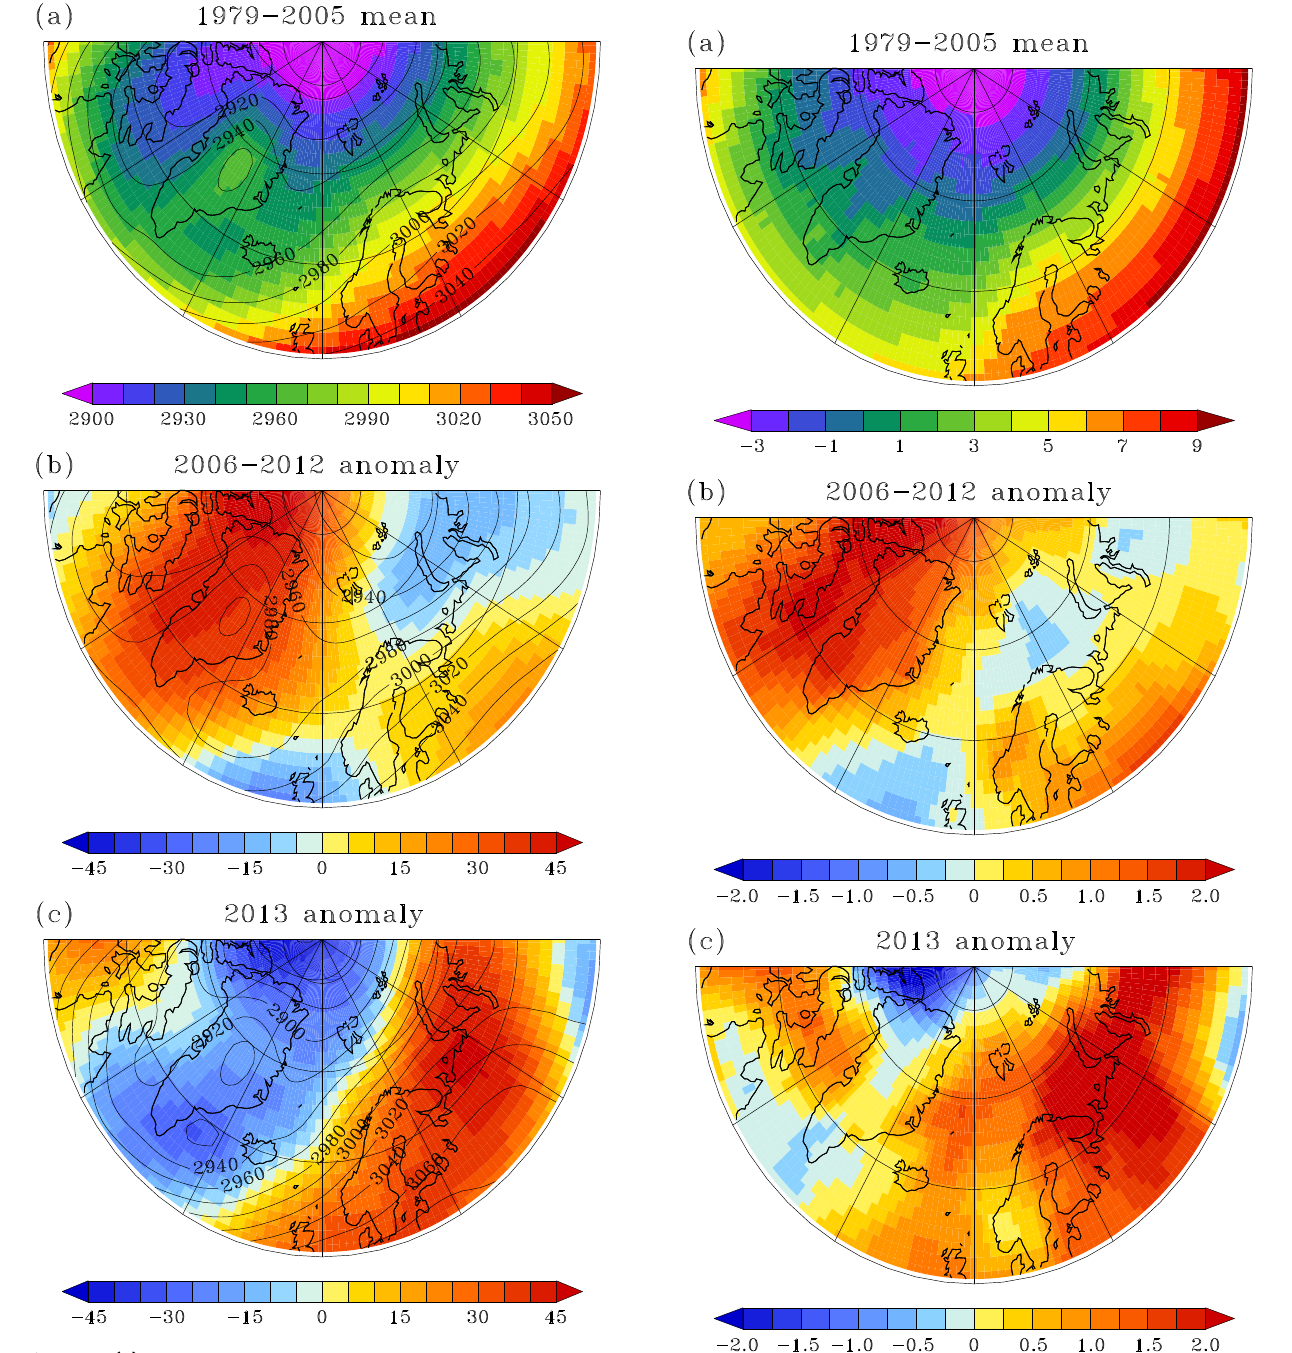
Figure 4. (a) Mean 1979–2005 JJA geopotential height at 700hPa (Z700 JJA ) (m) from ERA-Interim. (b) 2006–2012 mean z700 JJA anomaly (m) with respect to the 1979–2005 mean. (c) Same as (b) but for 2013. The black lines represent the mean Z700 JJA for each period.